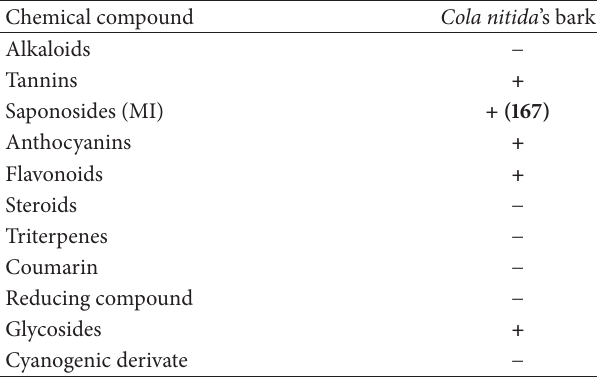
Table 1: Phytochemical composition of Cola nitida ’s bark powder.